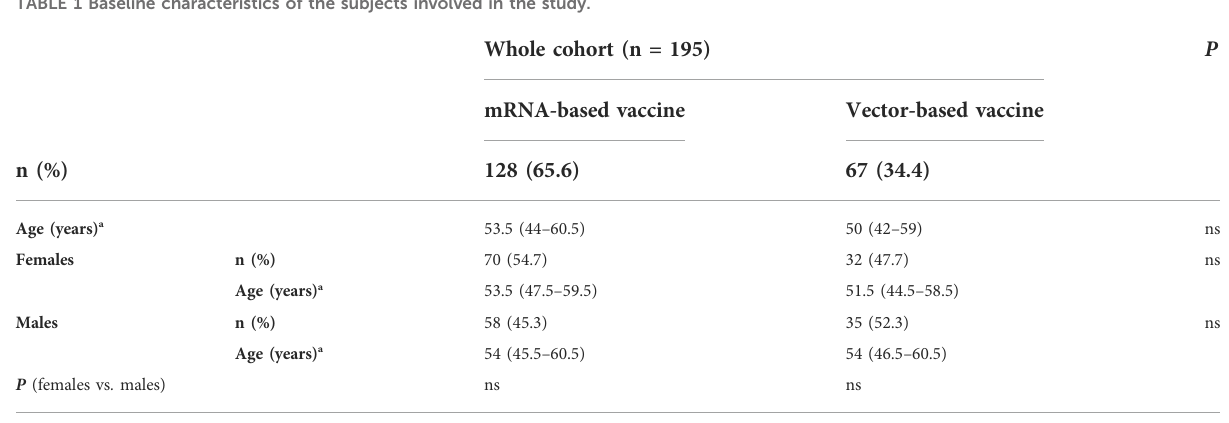
TABLE 1 Baseline characteristics of the subjects involved in the